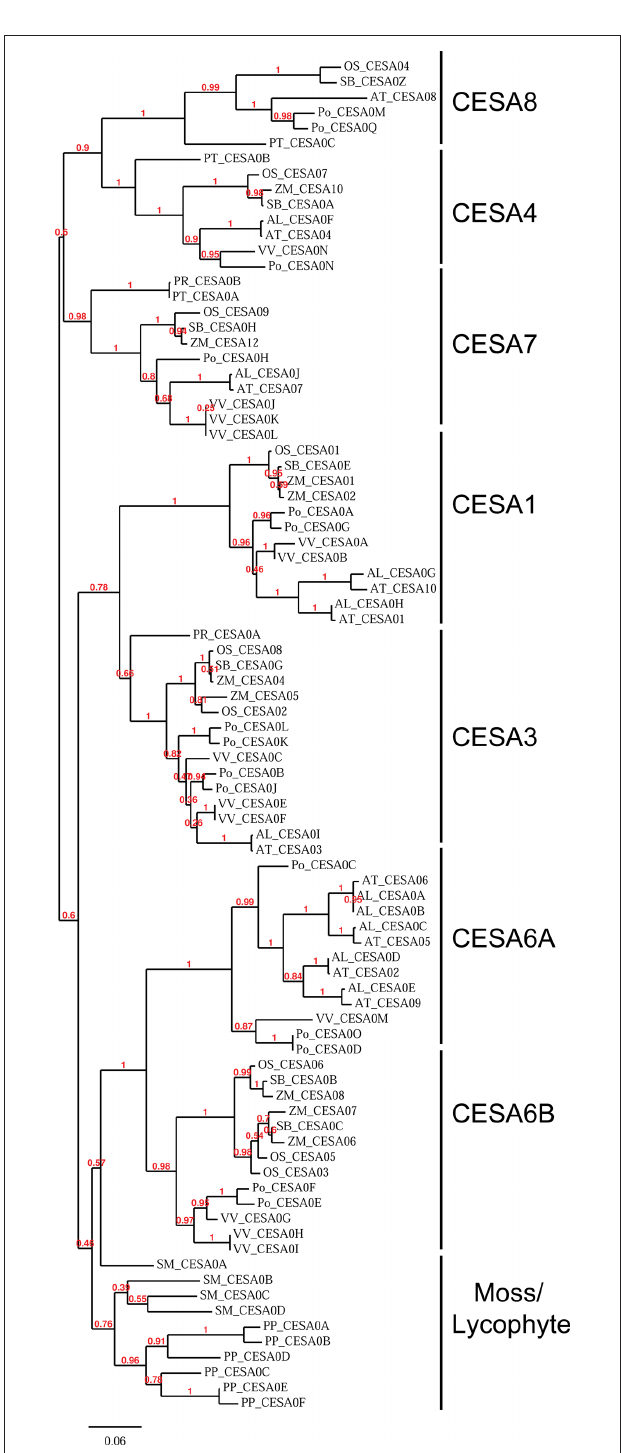
FiGuRe 1 | Phylogeny of the cellulose synthase family in land plants. A phylogenetic tree built using maximum likelihood by the program PhyML on the alignment of the CesA family. The phylogeny shows that the CesA family is divided into clades which correspond to the required CesAs in Arabidopsis. The clades are labeled based on their similarity to the identified Arabidopsis CesA. Numbers reported represent bootstrap values with 100 total bootstraps run. Organism abbreviations are listed in Table